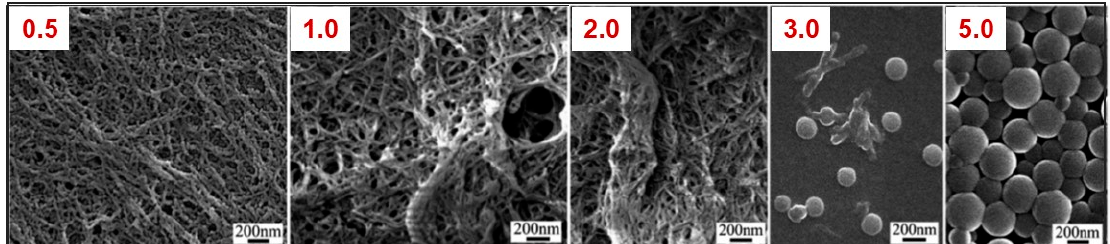
Figure 2 . SEM images of the polymers prepared from the reaction of 2,4-TDI and 4,4 ΄ -ODA in acetone at 30 °C for 4 h under reciprocating shaking (150 oscillations per min), at five different monomer concentrations (% w/w), as indicated. Adapted from Ref. [90] with permission from The Royal Society of Chemistry.